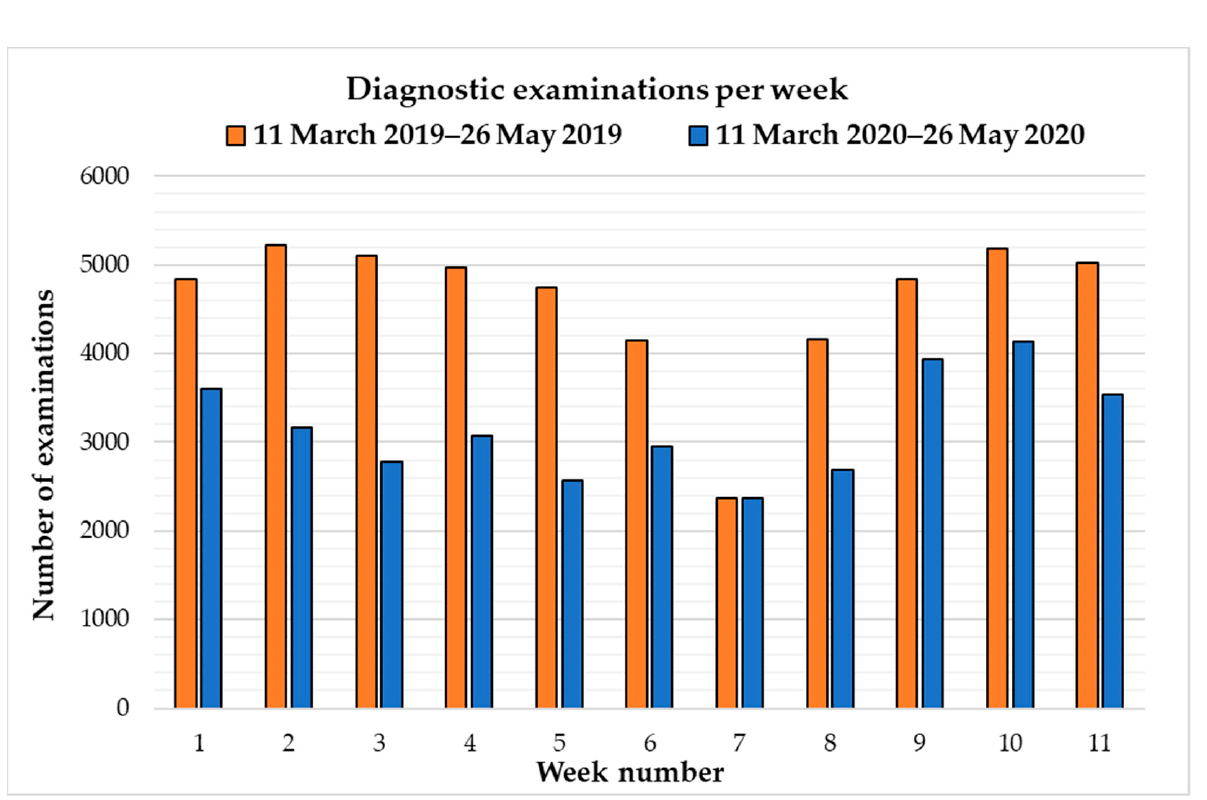
Figure 1. Graphical comparisons between the number of weekly diagnostic examinations performed during normal operativity (11 March 2019–26 May 2019, represented in orange) and the COVID-19 pandemic emergency period (11 March 2020 – 26 May 2020, represented in blue) in the radiology department of our hospital.